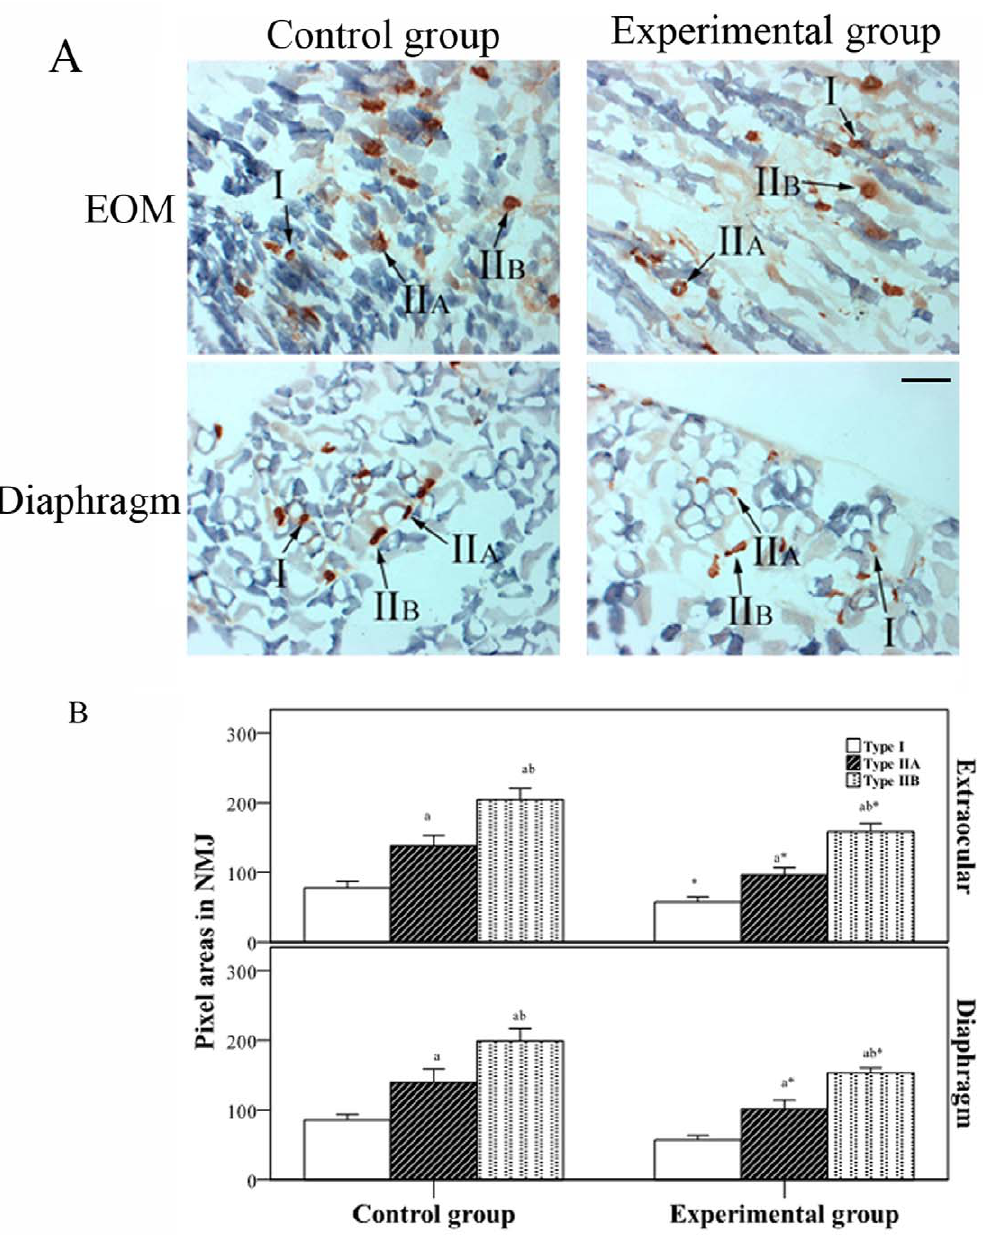
Figure 5. Comparision of the NMJ in different muscles by double-staining. A. SDH and AChR staining in EOM and diaphragm muscle fibers. B. Determination of pixel areas in neuromuscular junction by an automatic analyzer. *Significant ( P , 0.05) difference between control and experimental groups by independent two-sample t test. a Statistically significant difference between indicated group and type I muscle fibers. b Statistically significant difference between indicated group and type IIA muscle fibers. Scale bar=20 m